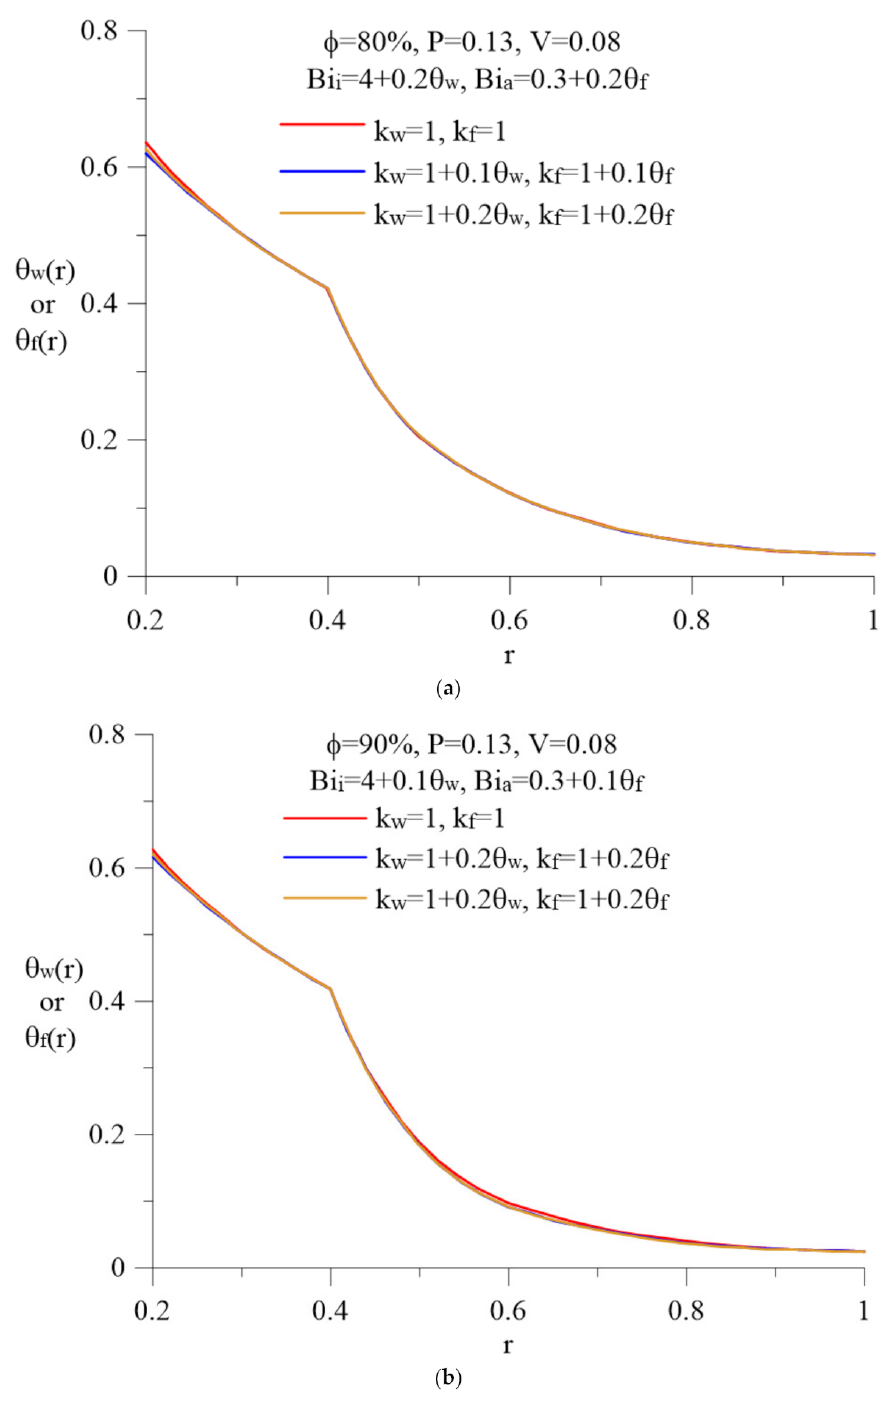
Figure 4. ( a ) The temperature variations of a rectangular fin with various k w and k f . ( b ) The temperature variations of a rectangular fin with various k w and k f